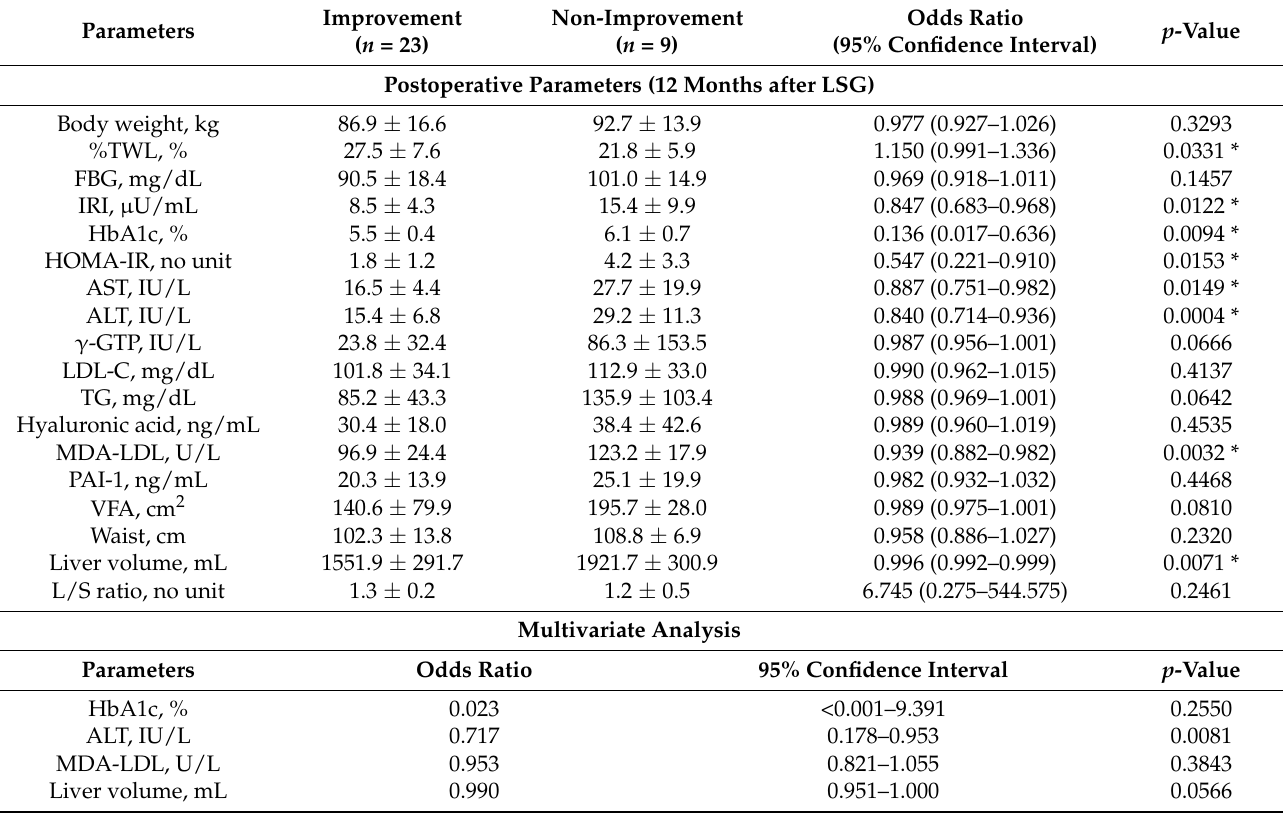
Table 4. Clinical features of patients with non-improved NASH after